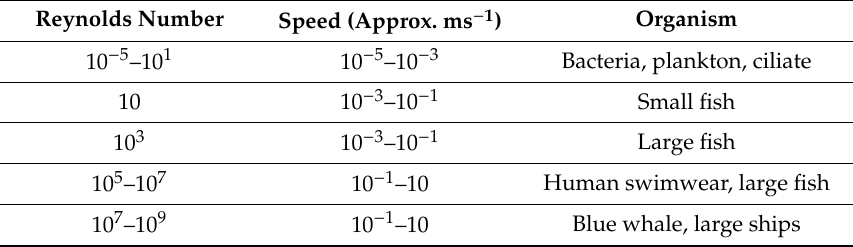
Table 3. The variation of Reynolds number in marine organisms with respect to speed.